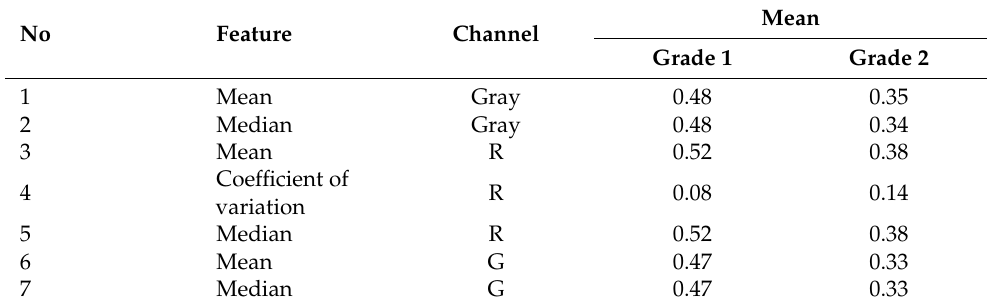
Table 1. The optimum features of dried white mulberry. Grades 1 and 2 represent high- and low- quality samples,